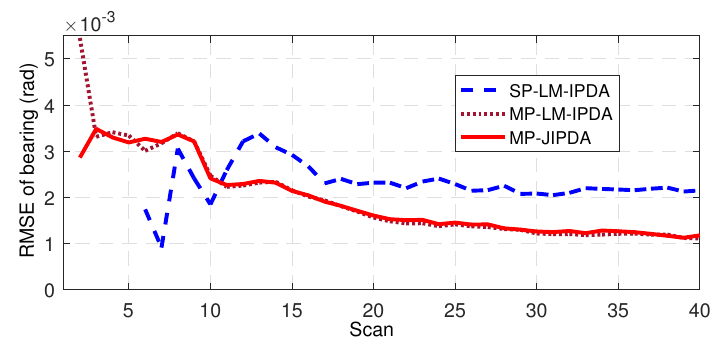
Figure 8. RMSE of bearing for Target 1.